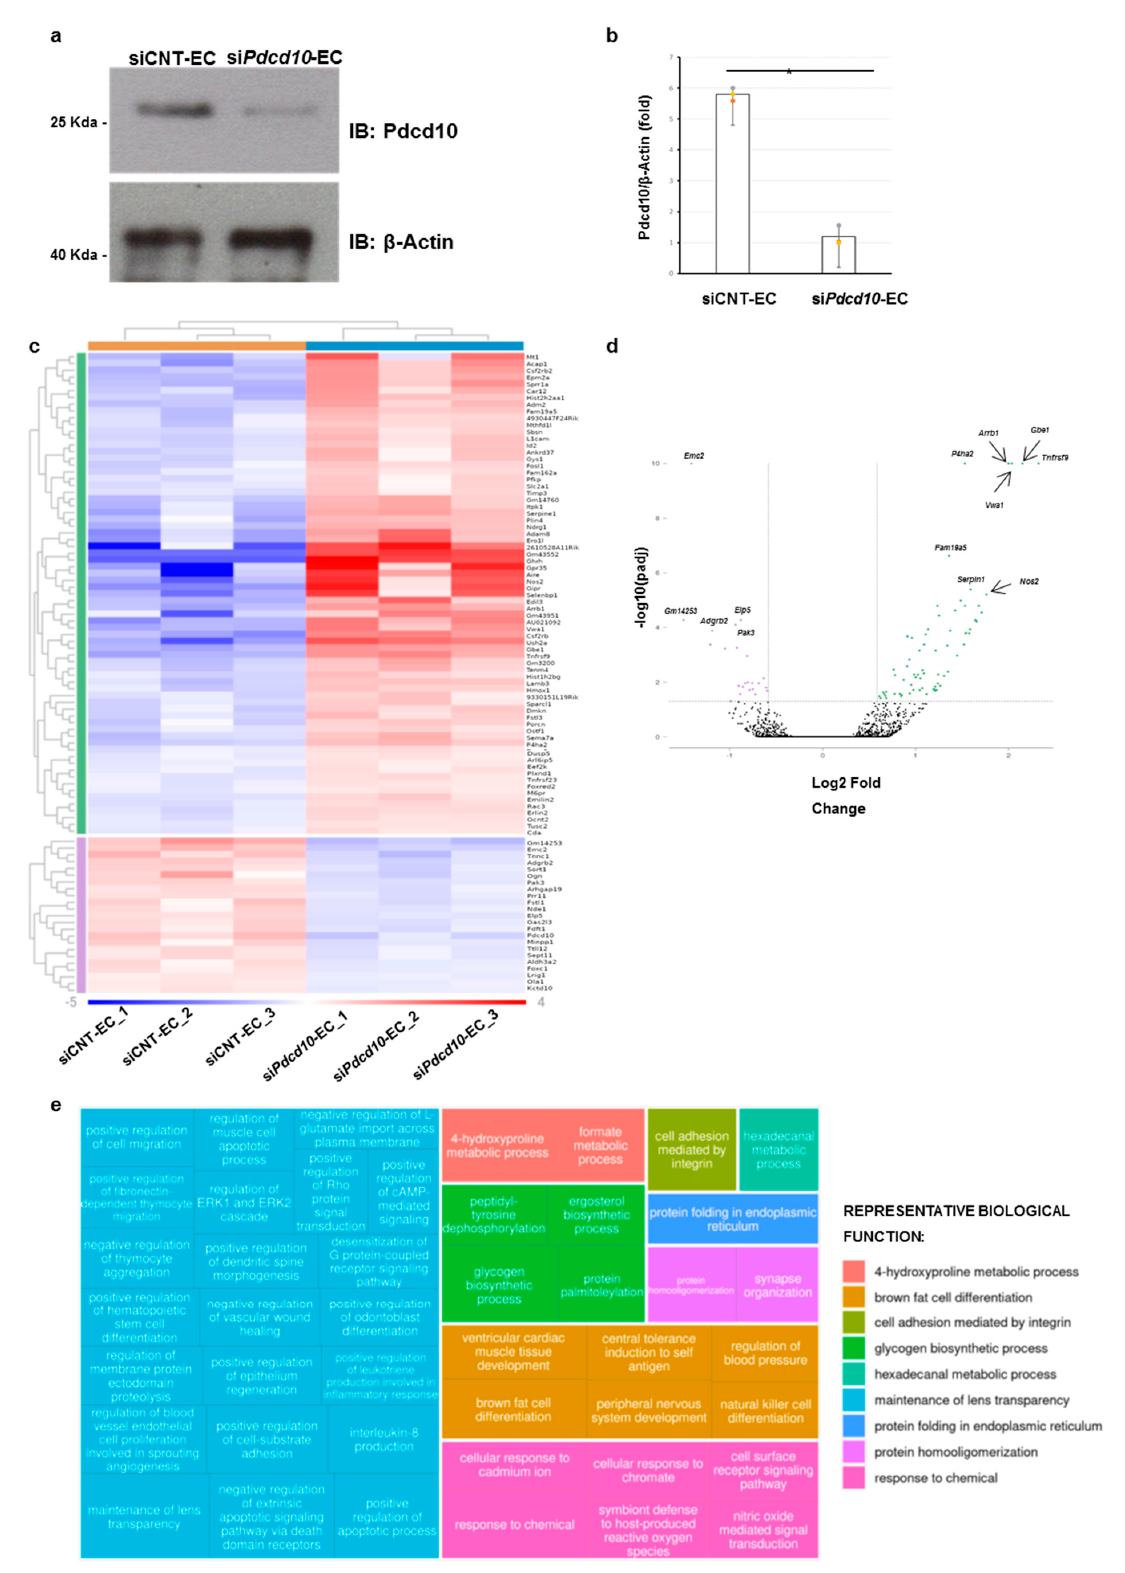
Figure 1. RNA-seq data. ( a ) Total lysates were obtained from si Pdcd10 -ECs compared to siCNT-EC, separated on 10% SDS-gel and subjected to immunoblotting with indicated antibodies. ( b ) Relative